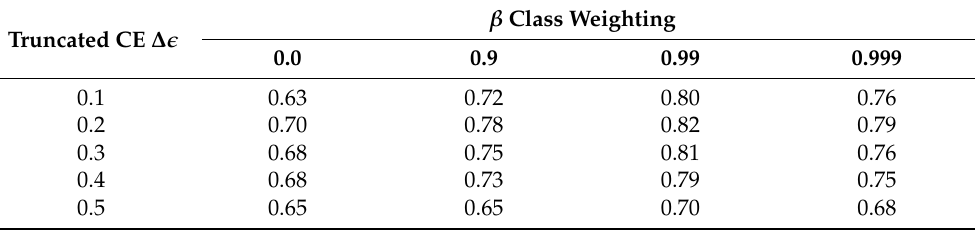
Table 6. Mean IoU of U-Net trained on aluminum alloy surface defect dataset with varying truncated cross-entropy loss thresholds ∆ (cid:101) and class weighting factor β